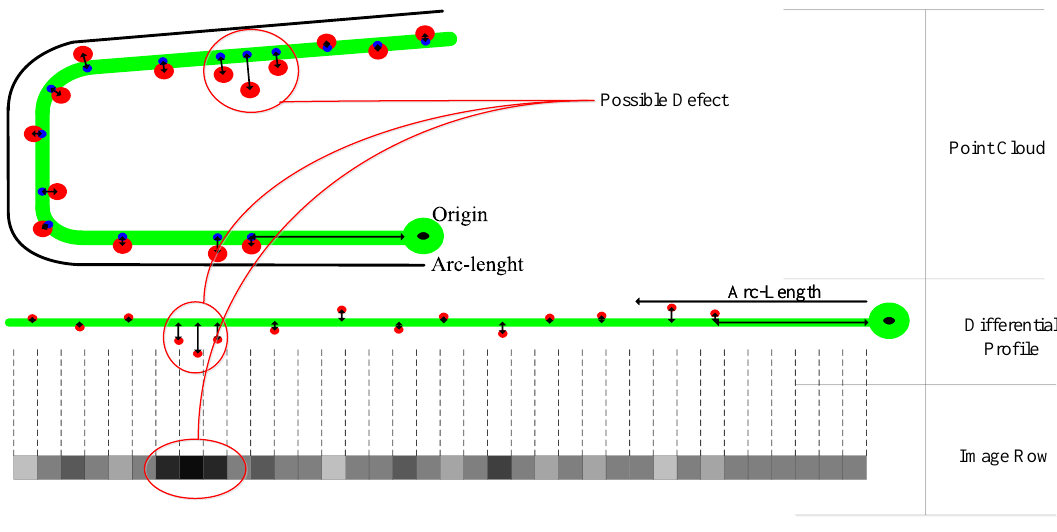
Figure 2. Acquisition and representation